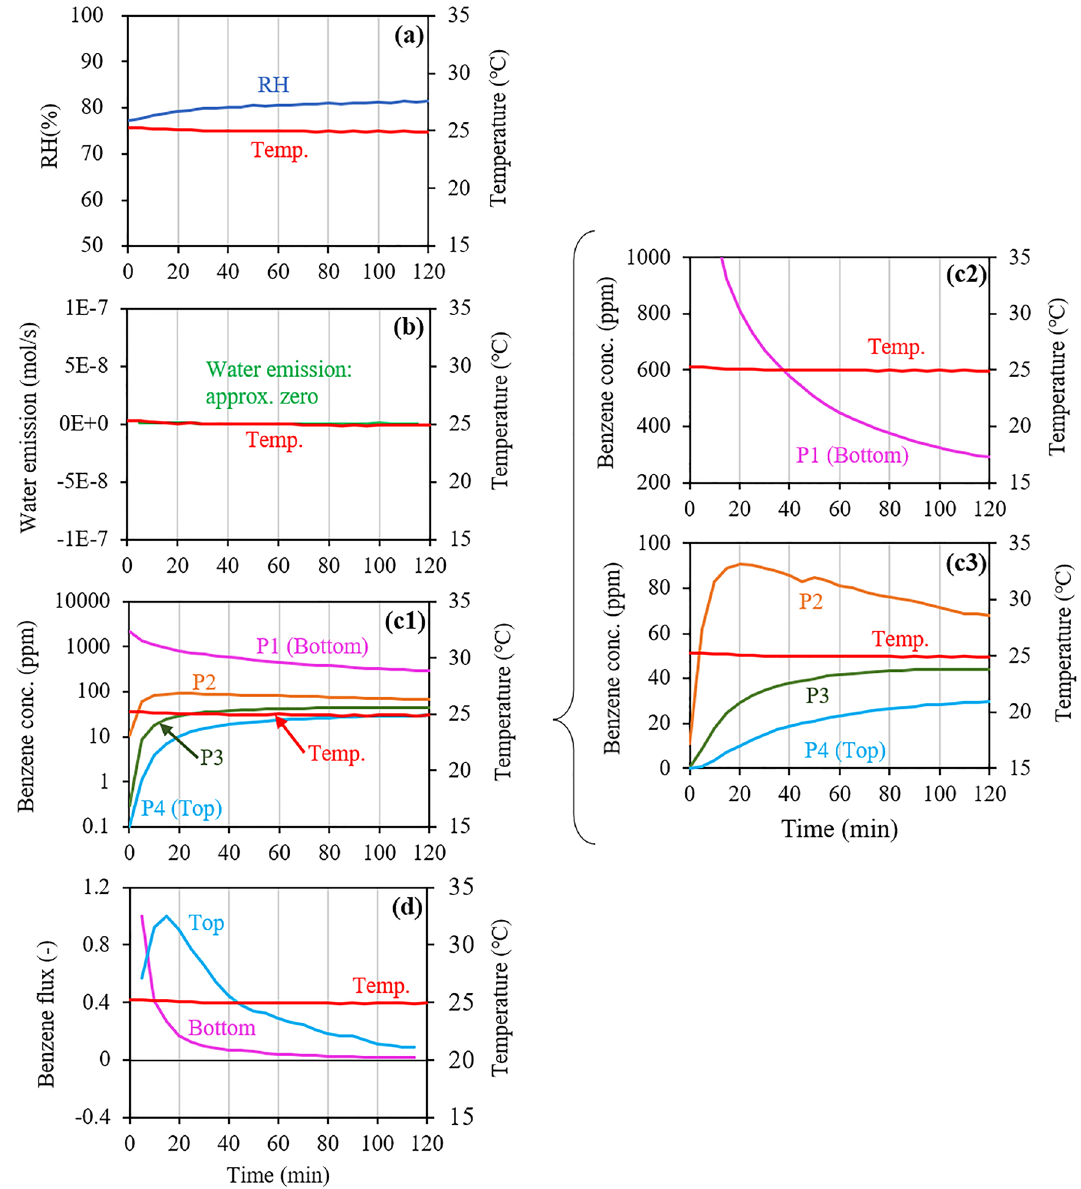
Figure 2. Changes in ( a ) relative humidity (RH) and ( b ) corresponding water emissions, ( c1 ‒ c3 ) benzene concentrations at the four ports (P1 ‒ P4), and ( d ) bottom and top benzene fluxes estimated from the concentration changes at P1 and P4, respectively, in Run 1 under static temperature of 25 °C. Note that the flux value at each time is represented by a ratio of the observed value at each time to the largest observed